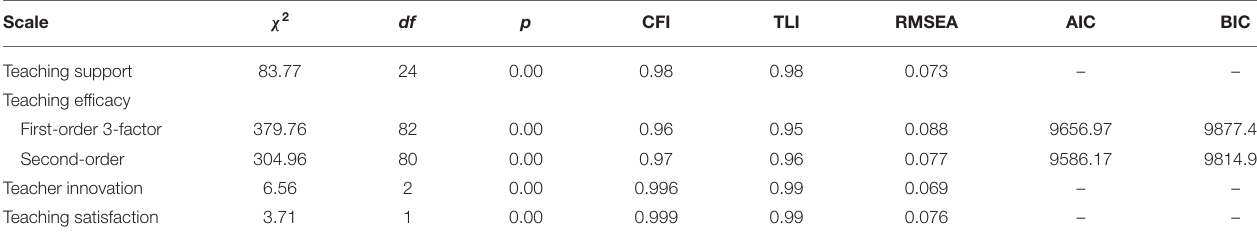
TABLE 1 | CFA results for the scales ( N =